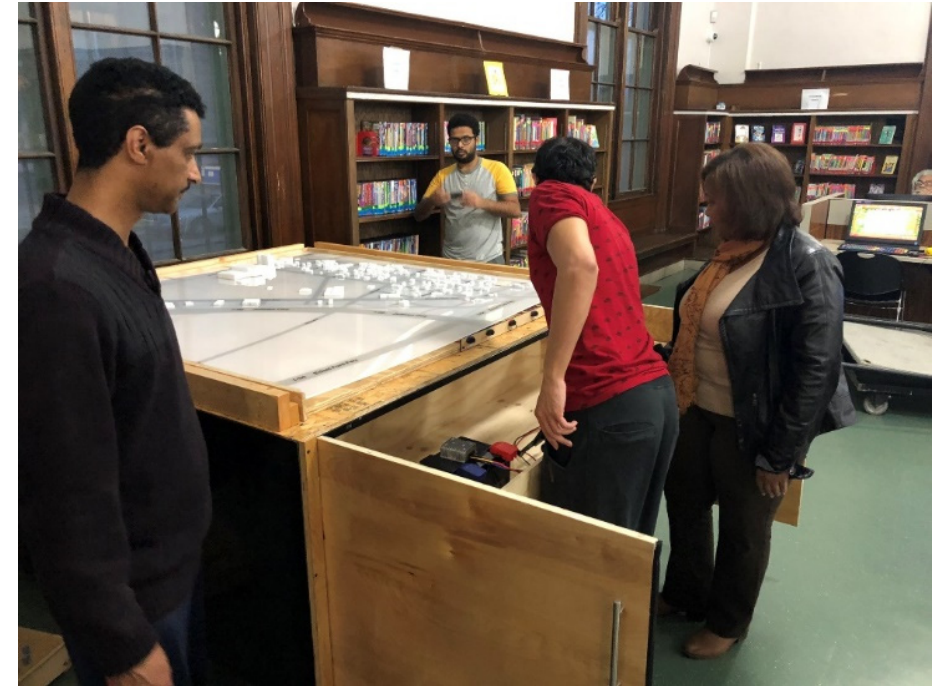
Figure 7. An MMS donated to and installed at the Detroit Public Library.